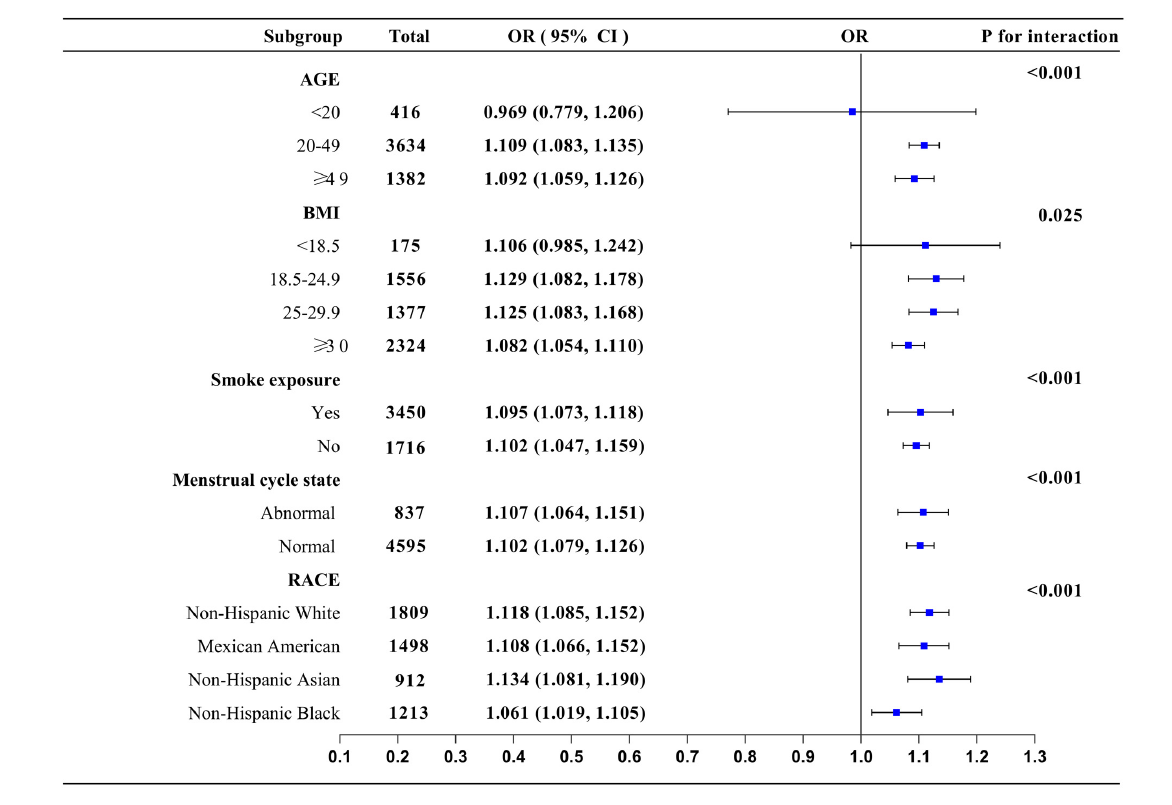
tissues, including elevated concentrations of pro-inflammatory cytokines and immune mediators in cerebrospinal fluid